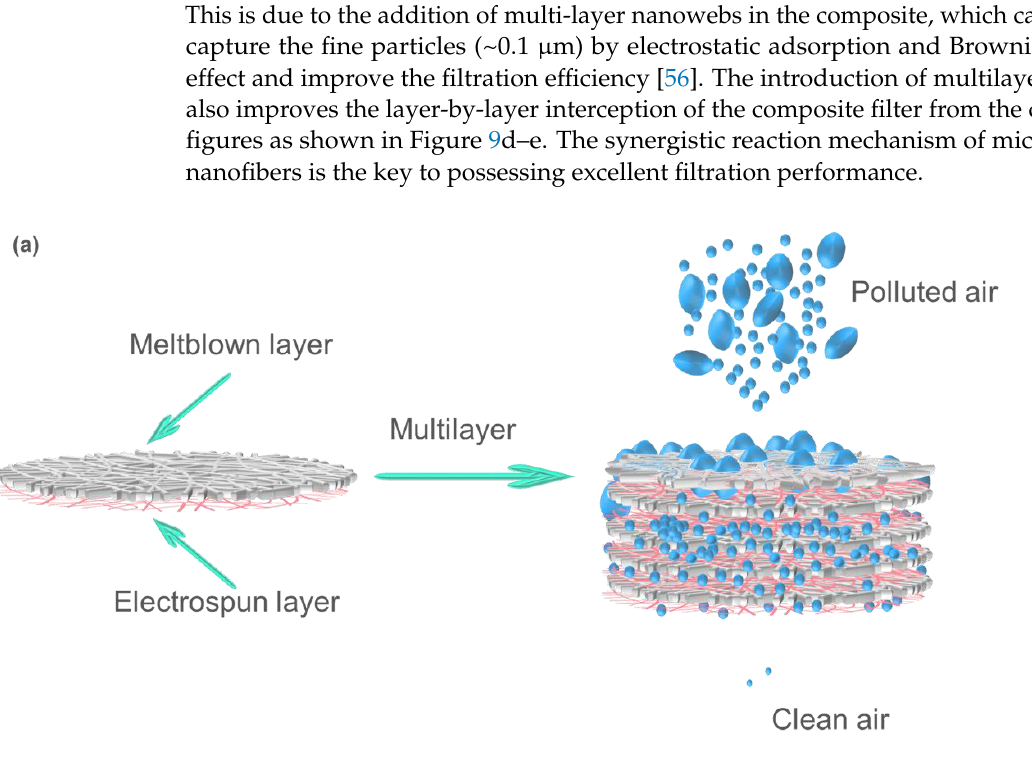
Figure 9. ( a ) Schematic diagram of filtration process. SEM images of M 3 E 3 *5 after loading ( b ) sur- face meltblown layer, ( c ) bottom nano layer, and ( d , e ) the cross section at different magnifications. 4. Conclusions In summary, the composite filters (18.5 gsm) were successfully fabricated by laminating 10 layers fiber-webs and exhibited satisfied filtration efficiency, low pressure drop, high quality factor, and dust holding capacity for NaCl aerosol particles. The ultrathin micro/nano fiber-webs in filters integrated the advantages of microfibers and nanofibers and enabled the composite to form a 3D structure with fine fibers, small pore size and high porosity. The increasing layers and thinning fiber-webs can improve the filtration efficiency and lower the pressure drop of the composite. The filtration efficiency of the composite filter still reached up to 96.48% after 80 days storage, avoiding the a decrease in the filtration efficiency due to charge decay on electret meltblown materials. The alternate arrangement of ultra-thin nano and melt-blown layers constructed a layer-by-layer interception and collaborative filtering effect in the composite filter,